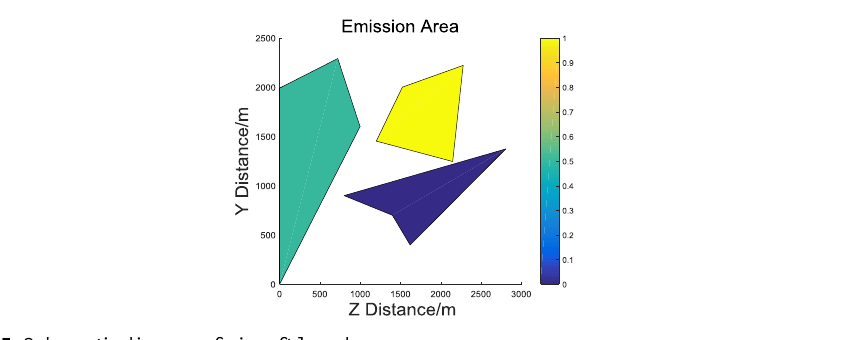
Fig. 5. Schematic diagram of aircraft launch area.